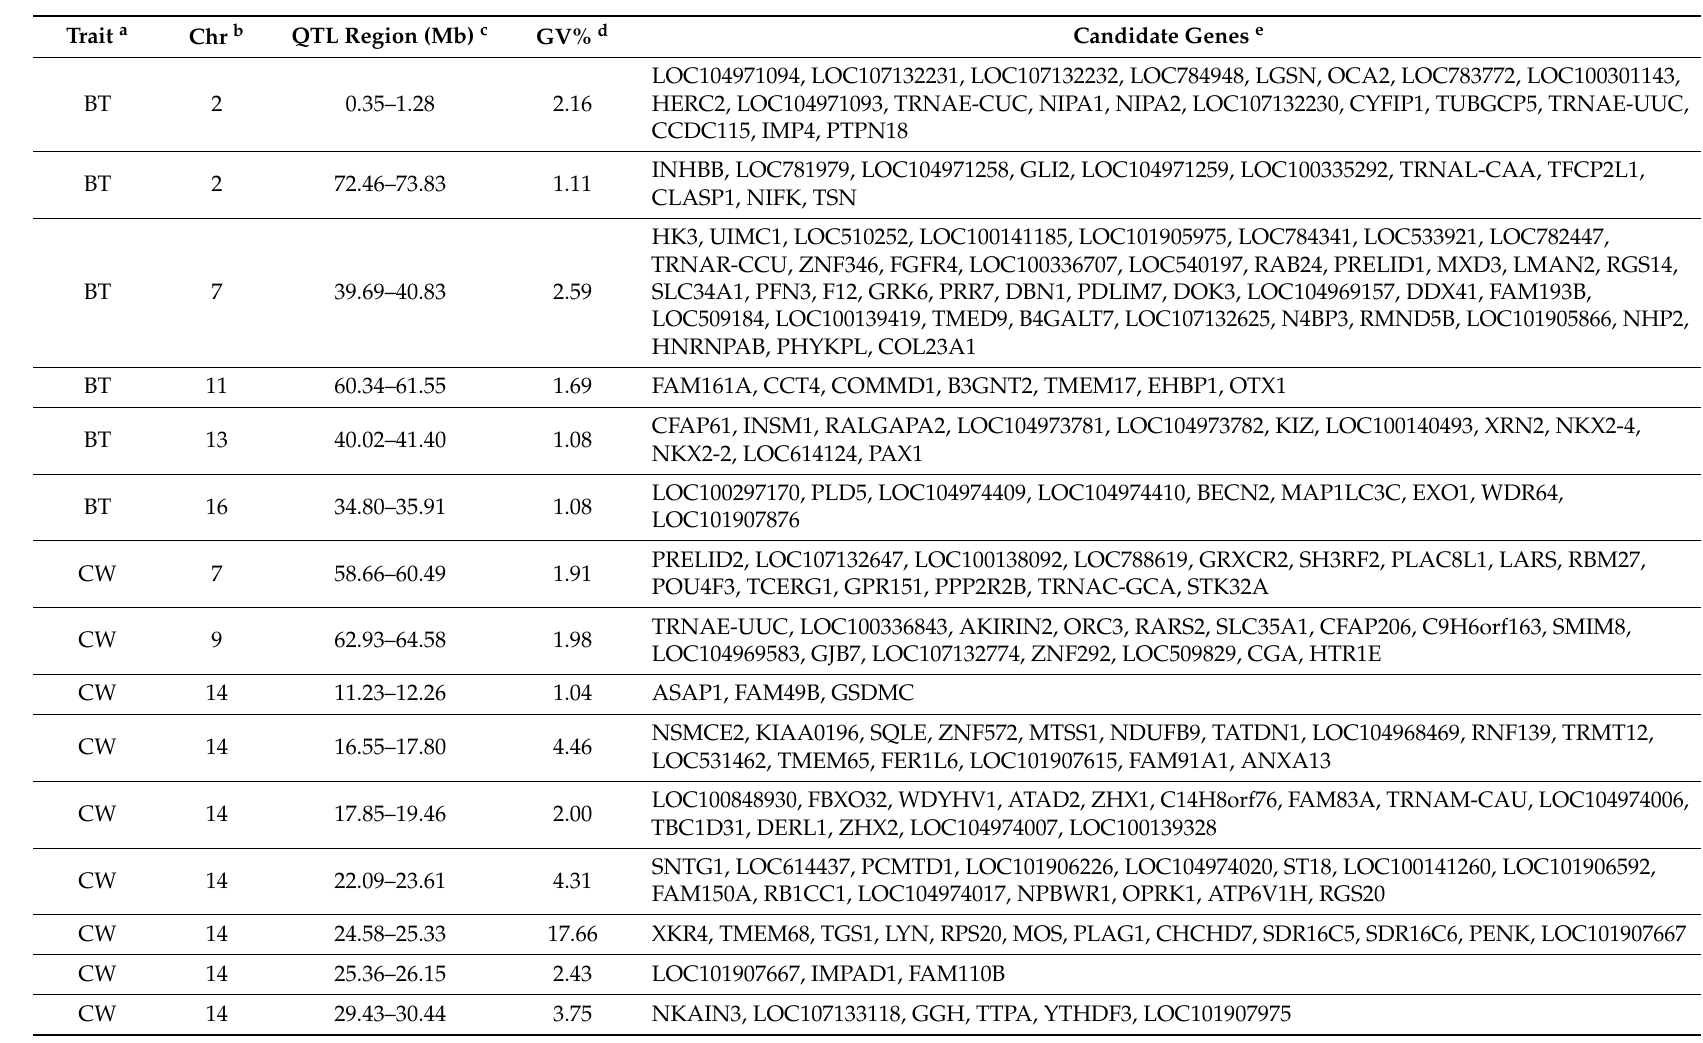
Table 2. Summary of SNP windows that explained > 1% of genetic variance for all studied traits in Hanwoo cattle, with a list of annotated genes within each window. Trait